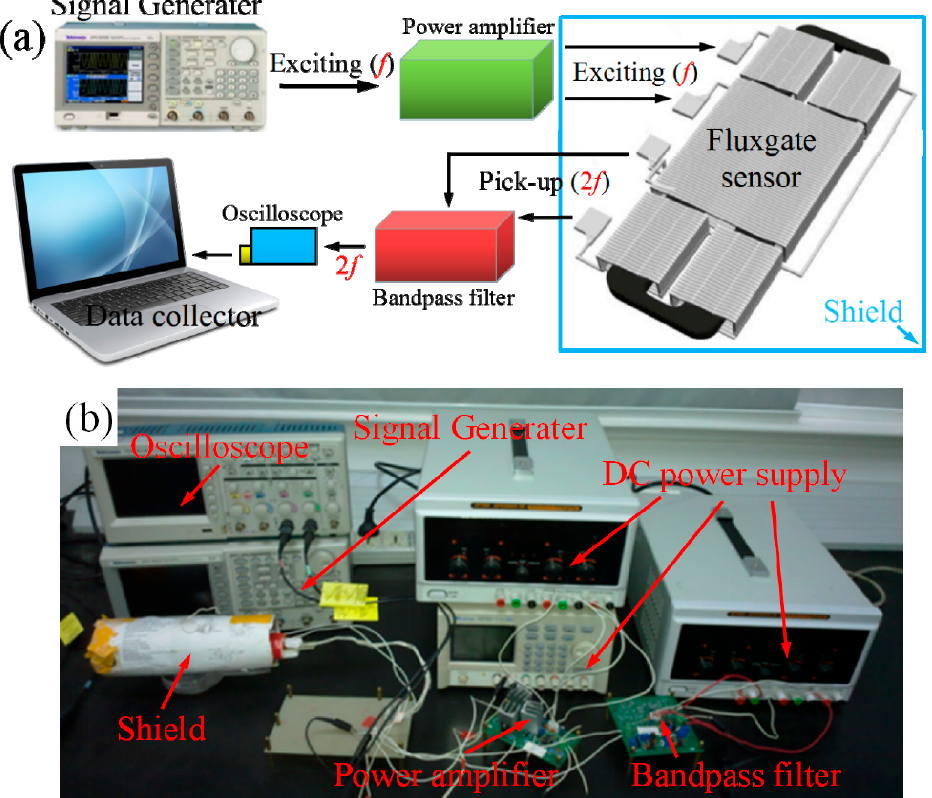
Figure 3. ( a ) Schematic illustration of test system circuit; ( b ) Photograph of the test system.